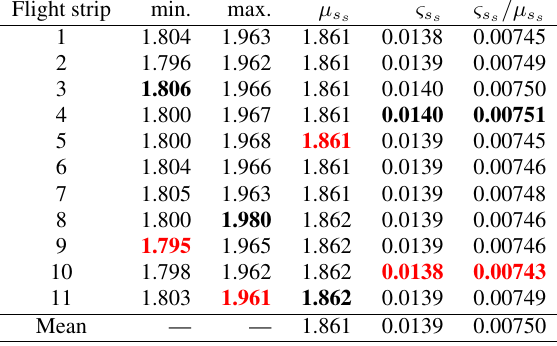
Table 2: Statistics for the system waveform widths s s of the 2004 campaign (unit: ns ). Bold figures denote the minima and maxima per category for the whole campaign, resp.